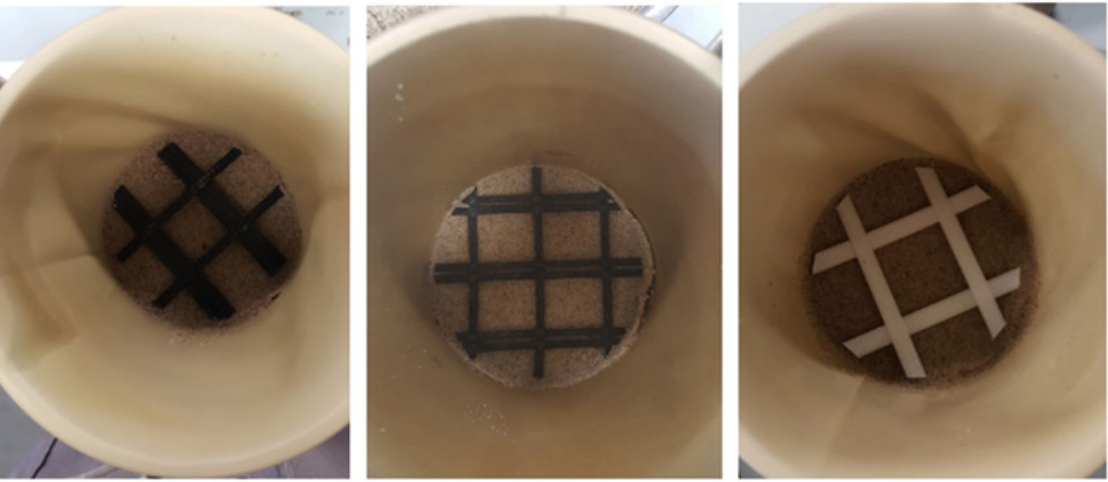
Figure 2: Sample reinforcement with geogrid: left – flexible Basetrac ® Grid PP 40 geogrid; middle – flexible Basetrac ® Grid PET 40 geogrid; right – rigid Secugrid 40/40 Q1